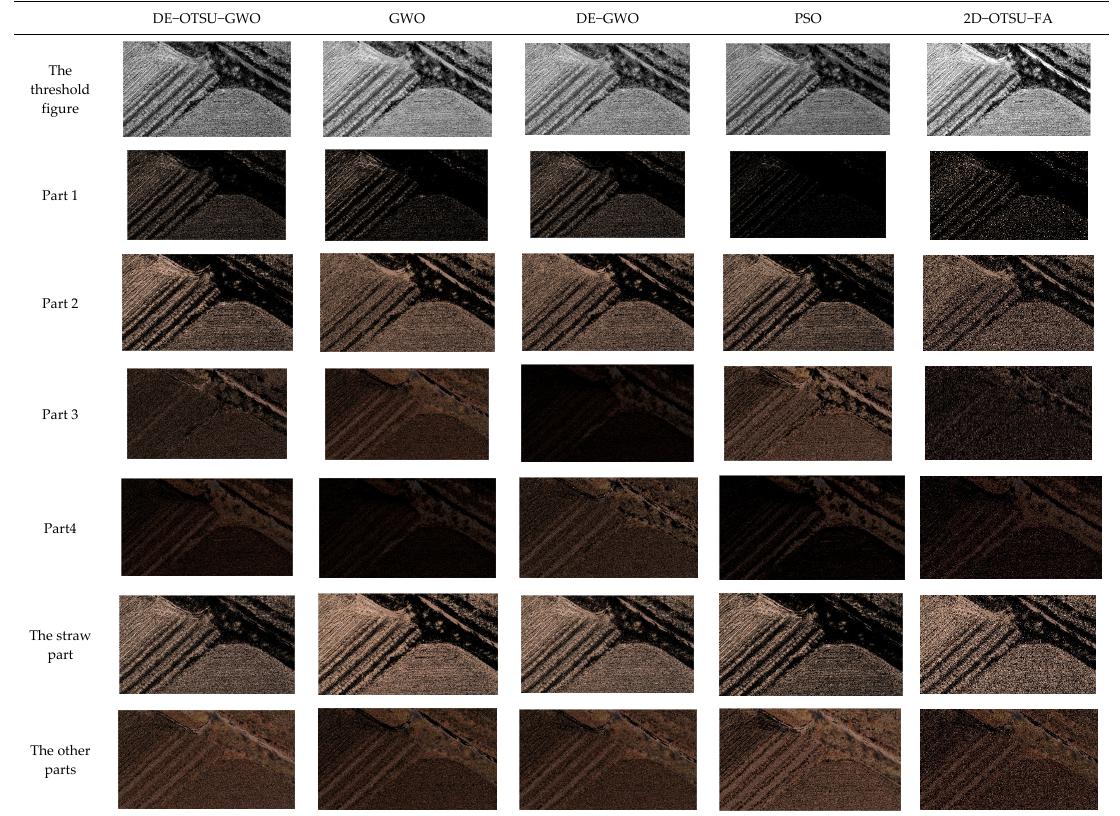
Figure 6. Image segmentation of five algorithms with the height of 100 m.